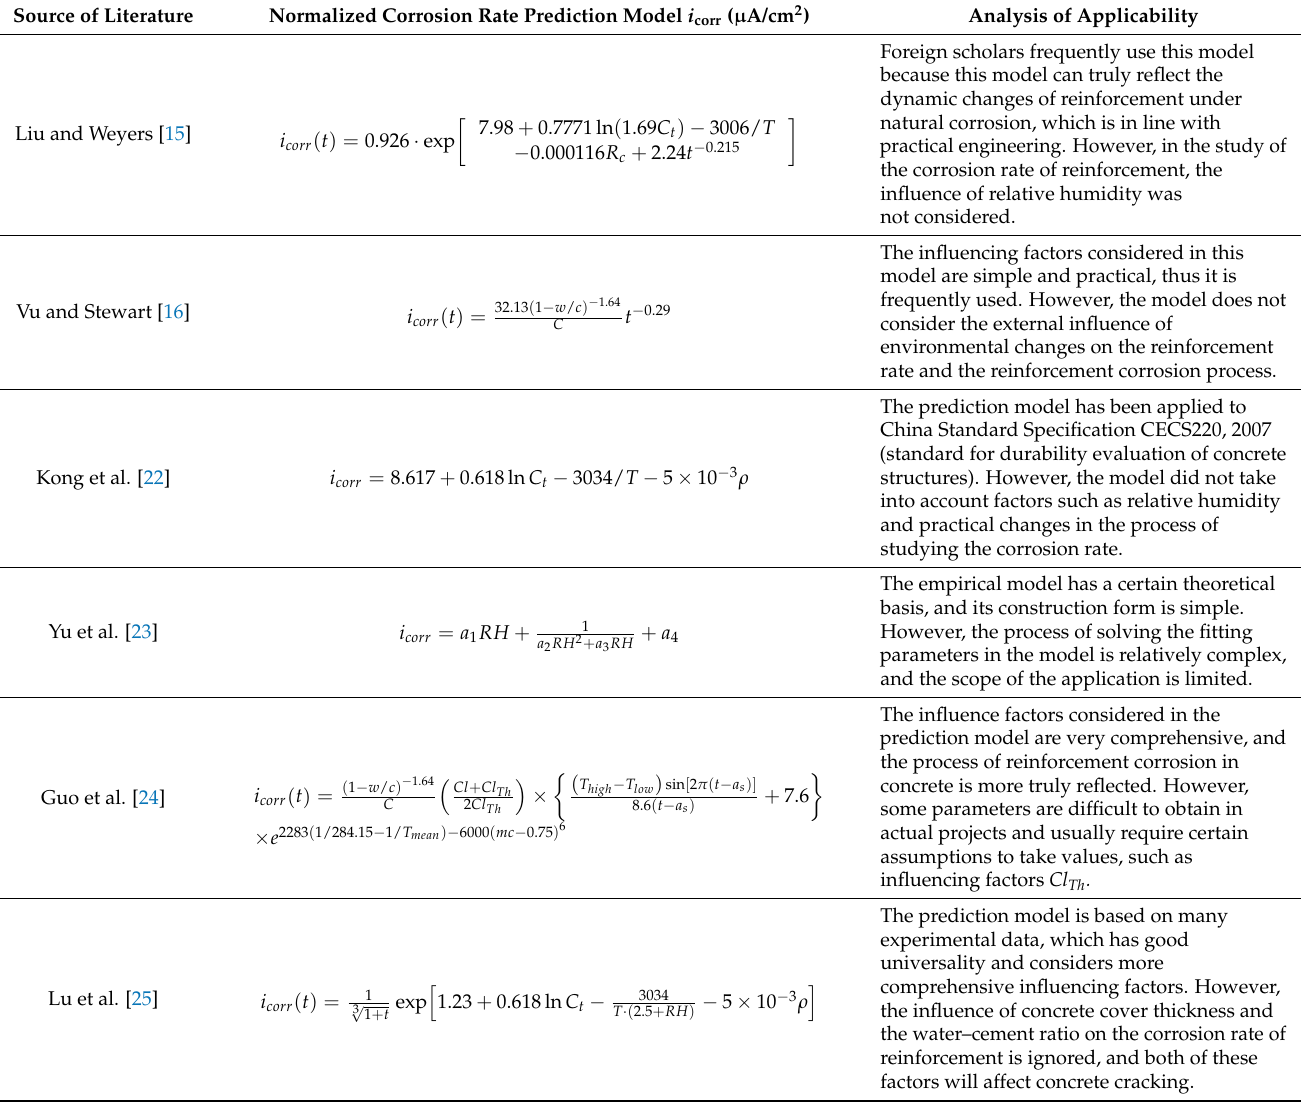
Table 1. Model analysis of corrosion rate of